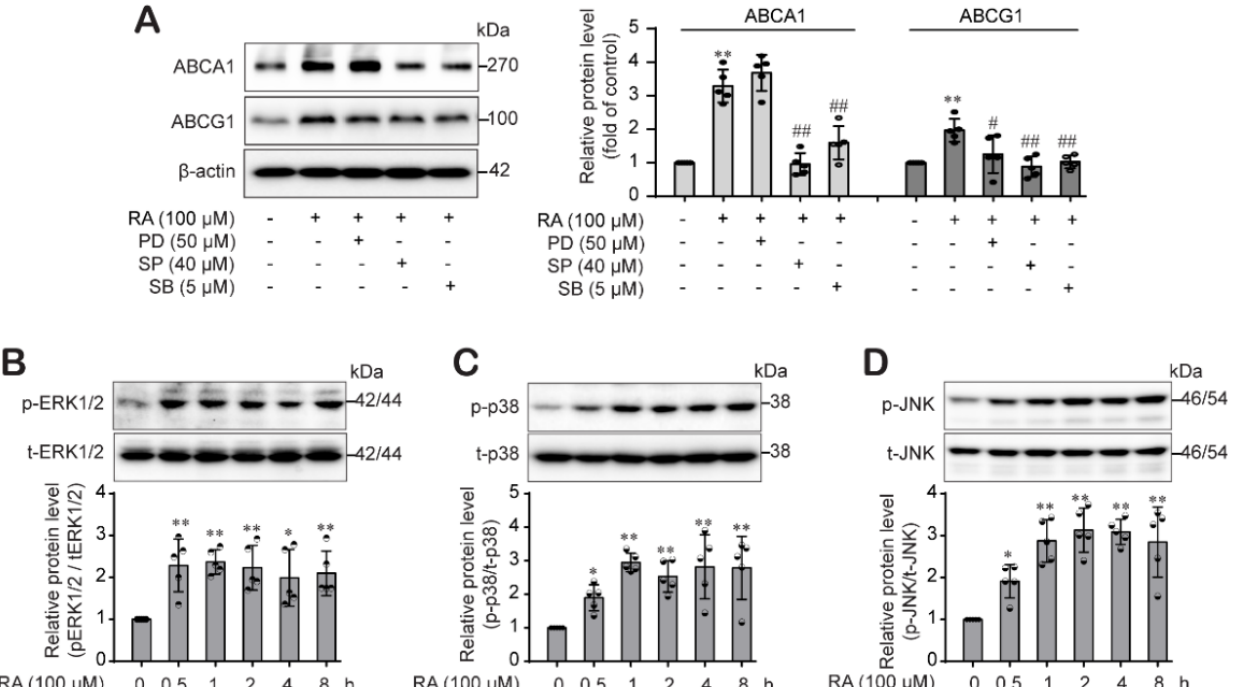
Figure 4. RA differentially regulates ABCA1 and ABCG1 protein expression through the MAPK signaling pathway. ( A ) THP-1 macrophages were pretreated with the MAPK inhibitors PD98059 (an ERK inhibitor, 50 μ M), SB203580 (a p38 inhibitor, 40 μ M) and SP600125 (a JNK inhibitor, 5 μ M) ( A ) for 1 h. Then, the cells were treated with RA (100 μ M) for 24 h, and ABCA1 and ABCG1 protein expression levels were analyzed by western blot analysis. ( B – D ) THP-1 macrophages were treated with RA (100 μ M) for various durations (0.5, 1, 2, 4 and 8 h), after which phospho-ERK1/2 ( B ), phospho-p38 ( C ) and phosphor-JNK ( D ) protein levels were determined by western blotting. Band densities were quantified and normalized for the loading controls β -actin or total ERK1/2, total p38 and total JNK. Relative protein levels are presented as the mean ± SD (n = 5). * p < 0.05, ** p < 0.01 compared to the control; # p < 0.05, ## p < 0.01 compared to the RA-treated group.